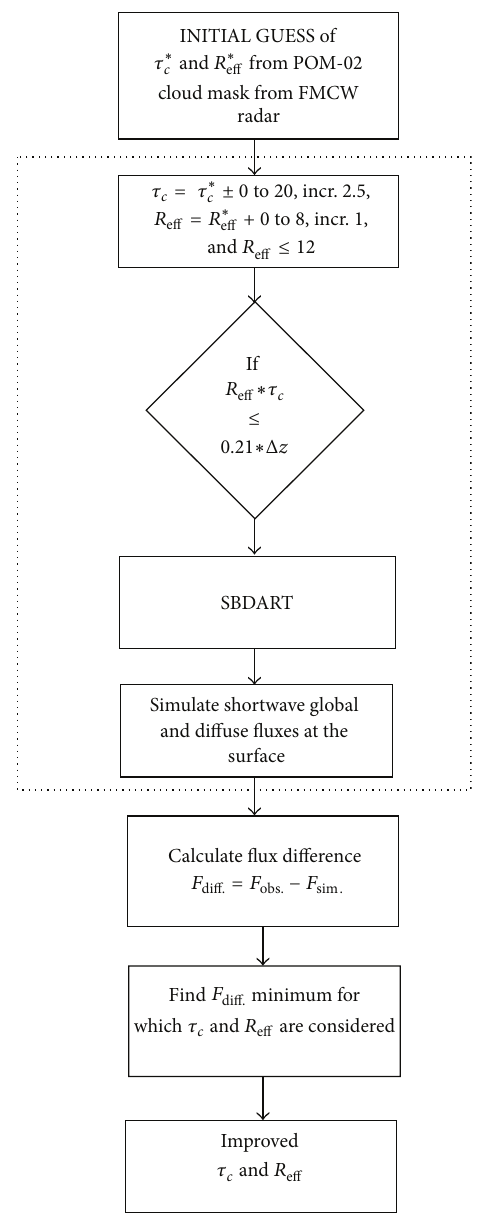
Figure 2: Flow chart of new retrieval algorithm for improved 𝜏 𝑐 and 𝑅 eff